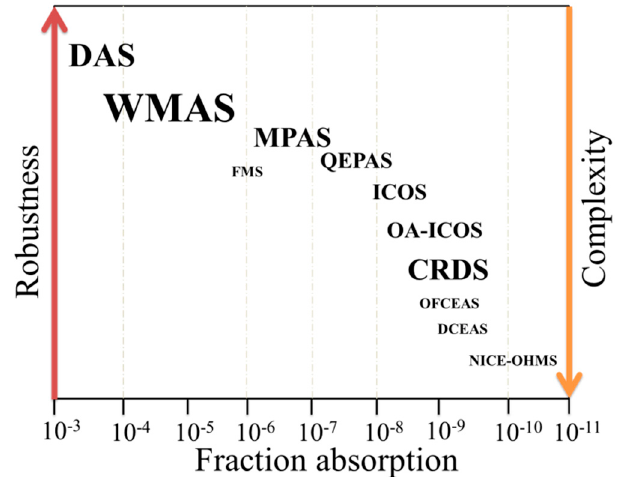
Figure 1. Different gas detection techniques are compared in terms of the sensitivity, complexity, and robustness of the sensor. The font sizes stand for their current importance for trace gases detection. DAS: direct absorption spectroscopy, WMAS: wavelength modulation absorption spectroscopy,